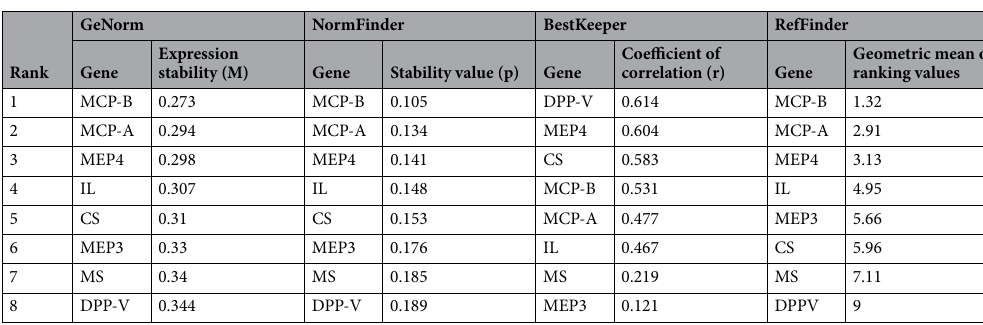
Table 2. Ranking of Virulence genes of T. mentagrophytes on the basis of their expression stability determined by geNorm, NormFinder, BestKeeper, and